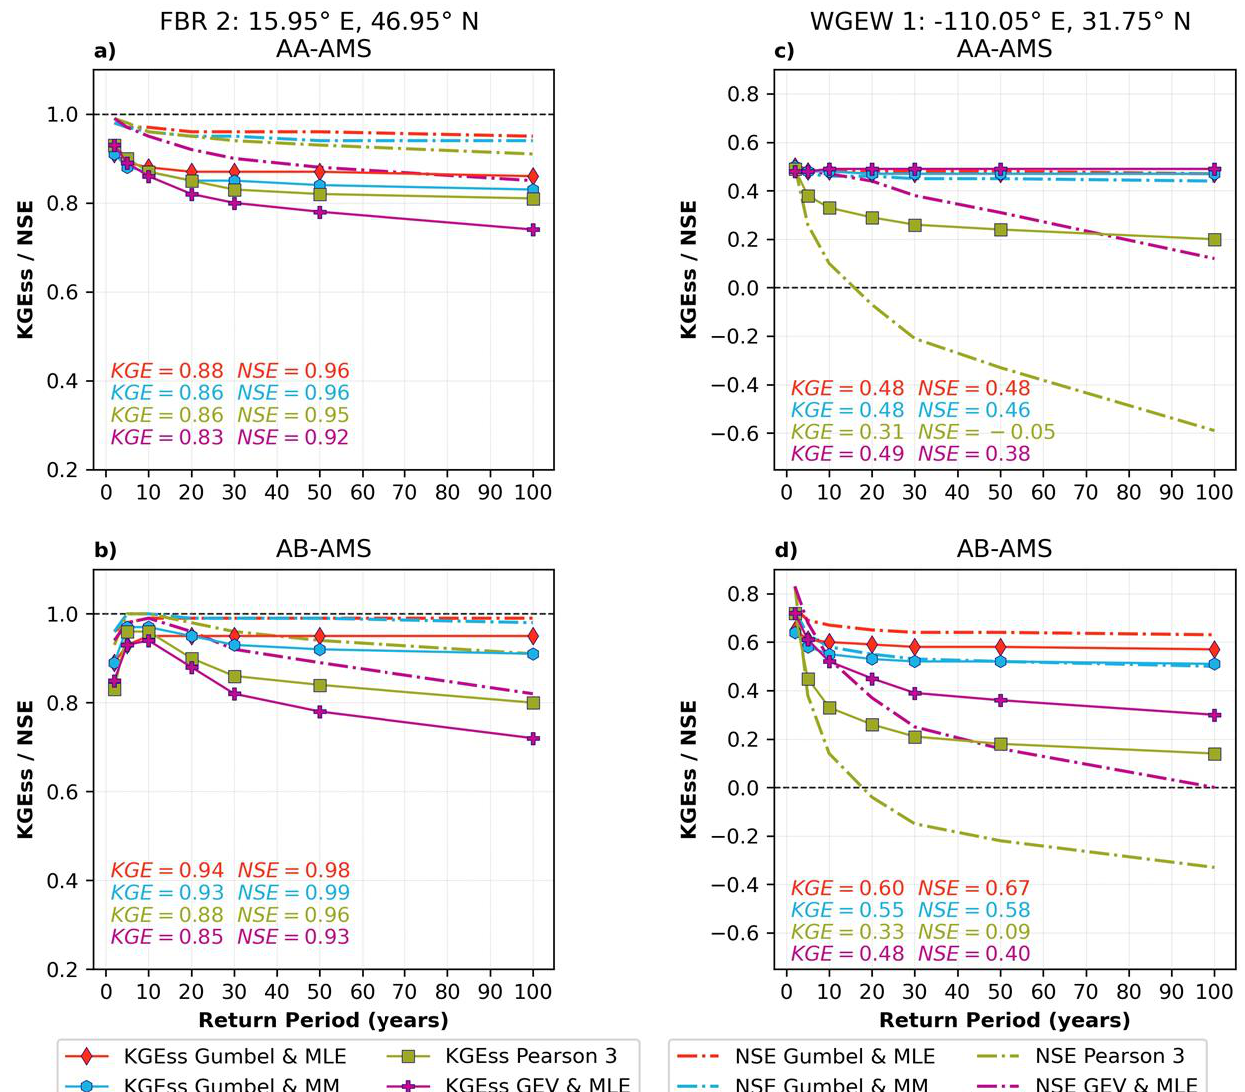
Figure 6. KGEss and NSE obtained for the four CDFs and the return periods 2, 5, 10, 20, 30, 50, and 100 years over FBR 2 ( left ) and WGEW 1 ( right ). IMERG IDF vs. AA-AMS IDF (subplots a , c ) and IMERG IDF vs. AB-AMS IDF (subplots b , d ). The solid lines with markers are for the KGEss and the dashed lines are for the NSE.